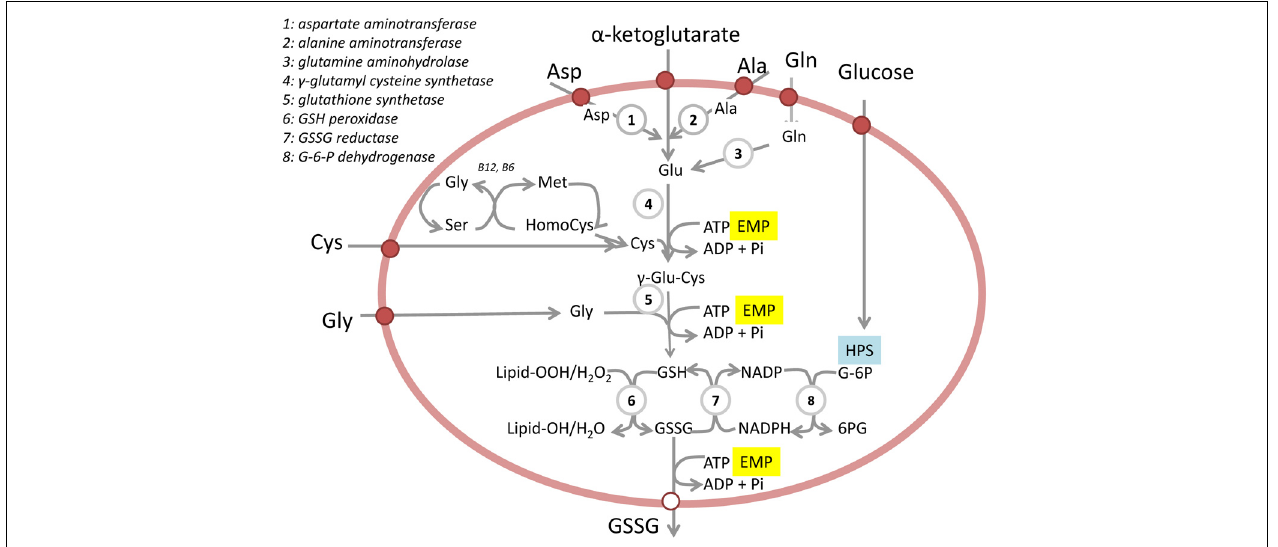
FIGURE 1 | Glutathione production and turnover in RBC. Schematically presented are substrate delivery, glutathione synthesis, and glutathione handling in RBC. EMP stands for Embden-Meyerhof pathway (anaerobic glycolysis). HPS denotes hexose monophosphate shunt (pentose phosphate